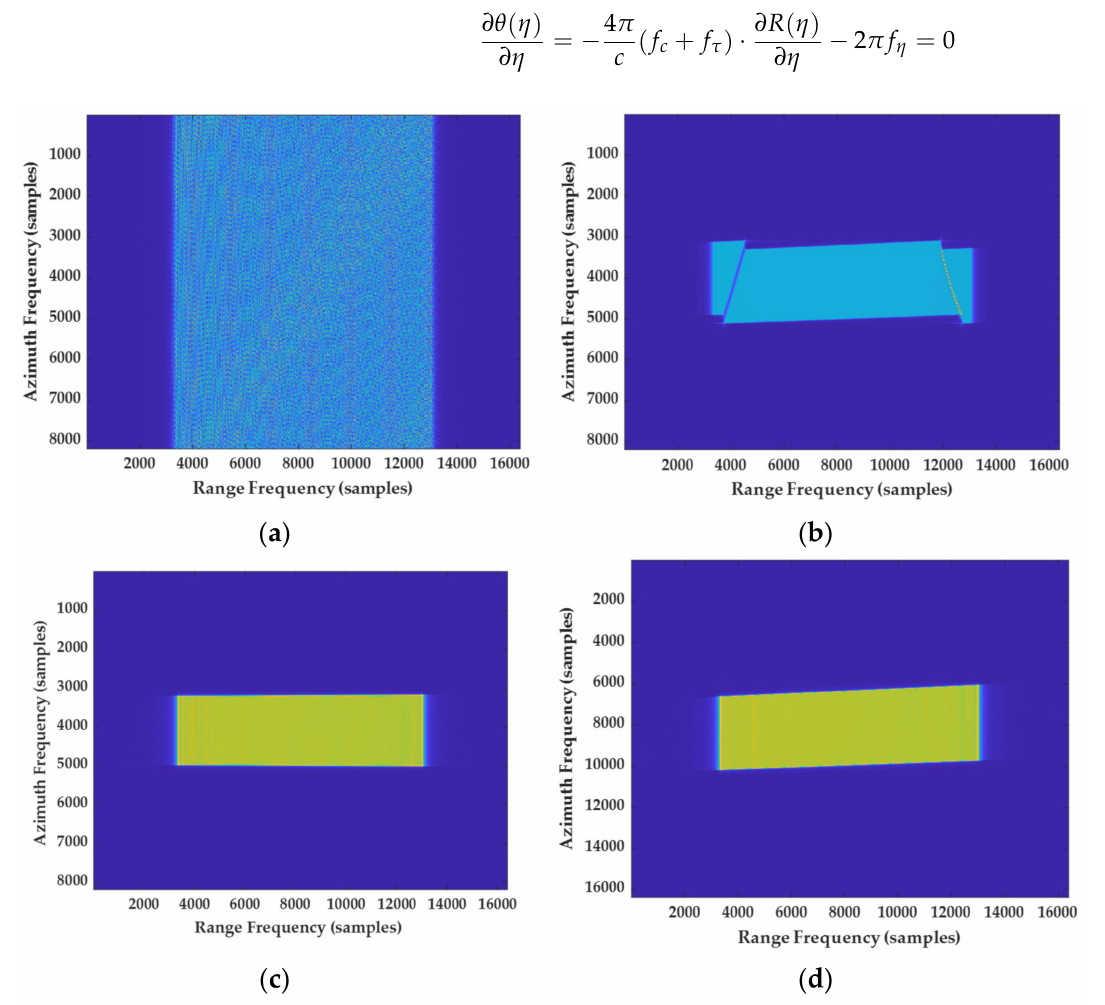
Figure 11. Illustration of preprocessing in squinted HEO sliding spotlight SAR. ( a ) Original 2D–spectrum. ( b ) After Deramp operation without nonlinear phase correction. ( c ) After Deramp oper–ation with nonlinear phase correction (see paragraph from Equations (11) and (12)). ( d ) Performing spectrum expansion based on result of ( c